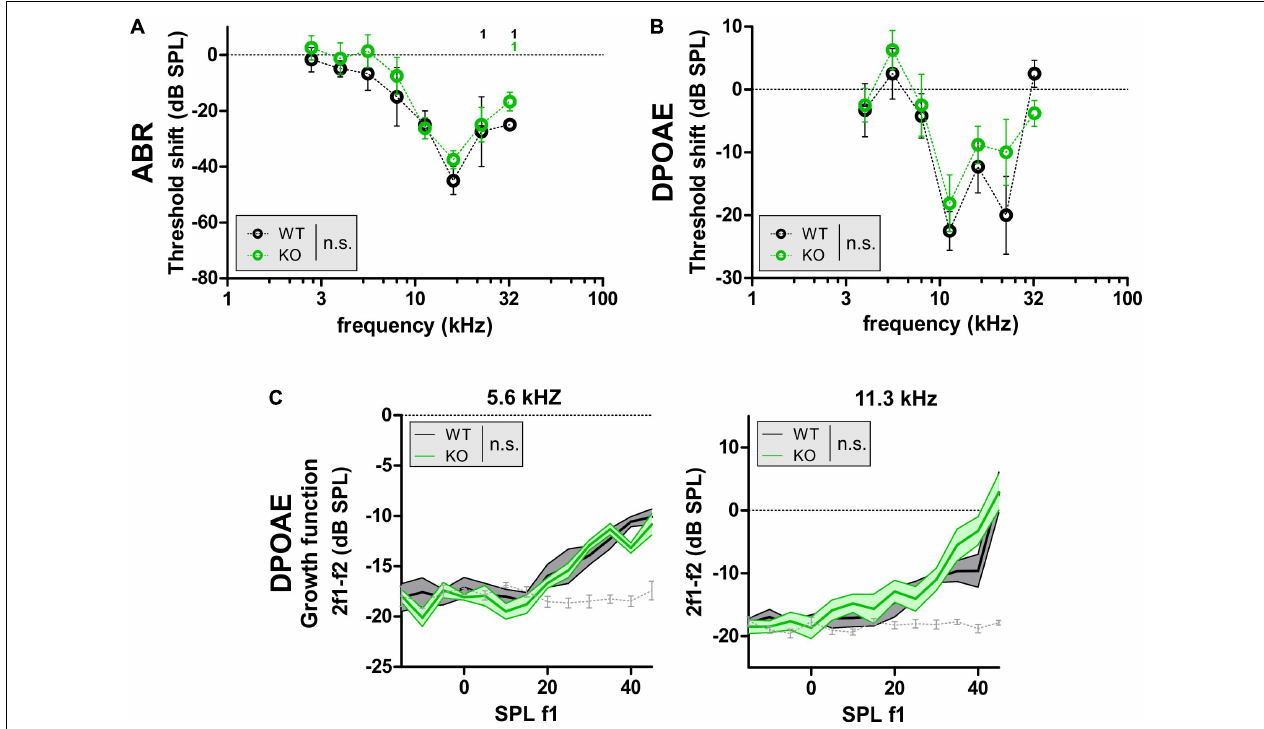
FIGURE 4 | DPOAE signals in GC-A WT and GC-A KO mice after acoustic trauma. (A–C) ABR threshold and OHC function, assessed by DPOAE measurements 7 days after acoustic trauma induction in young GC-A WT and KO mice. (A,B) Shift of frequency-specific ABR thresholds and DPOAE thresholds, when compared before and 7 days after acoustic trauma, did not show differences between WT and KO mice [f-ABR: two-way ANOVA, F (1,44) = 3.11, P = 0.0845, WT n = 3/3 mice/ears KO n = 4/4 mice/ears; DPOAE: two-way ANOVA, F (1,84) = 1.43, P = 0.2344, WT n = 3/6 mice/ears KO n = 4/8 mice/ears]. (C) DPOAE signal growth function in response to pure tones at f1 = 5.6 and 11.3 kHz were similar between GC-A KO and WT mice after acoustic trauma [5 kHz: two-way ANOVA, F (1,147) = 2.31, P > 0.05, WT n = 3/6 mice/ears KO n = 4/8 mice/ears; 11 kHz: two-way ANOVA, F (1,147) = 1.46, P > 0.05, WT n = 3/6 mice/ears KO n = 4/8 mice/ears]. DPOAE signal growth function in response to pure tone sounds at f1 = 22 kHz were also smaller in GC-A KO than WT mice after acoustic trauma [two-way ANOVA, F (1,147) = 11.51, P = 0.0009, WT n = 3/6 mice/ears KO n = 4/8